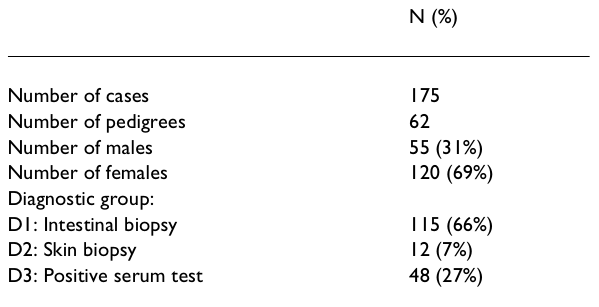
Table 1: Characteristics of CD Cases in the Study Population *